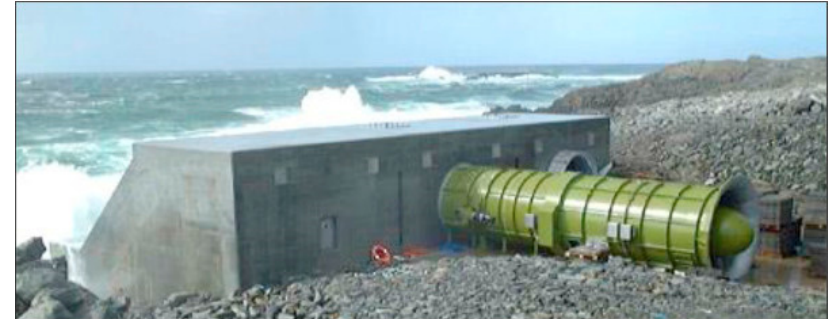
Figure 10. LIMPET OWC plant installed on the island of Islay (Scotland, UK) (Reproduced with permission 5139250512092 from [50], Elsevier, 2016).